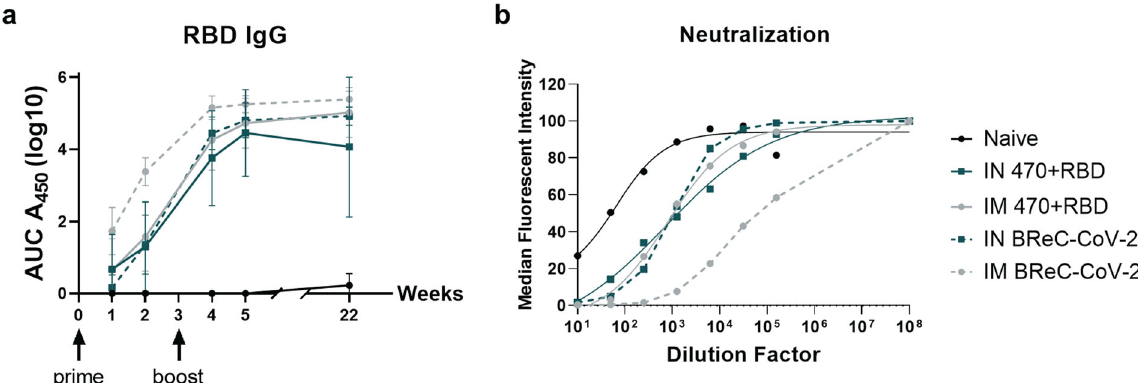
Fig. 2 Analysis of antibody responses and neutralization capacity of IN and IM BreC-CoV-2 vaccines. CD-1 mice were IN or IM vaccinated with BECC470 with RBD or RBD- EcoCRM ® in two doses. a Serum was taken at 1 week and 2 weeks post prime, 1 week and 2 weeks post boost and 22 weeks post boost. Log10 AUC450 values from RBD-IgG titers are depicted for each vaccine. Results shown as mean ± SD. b In vitro neutralization assay performed on the Luminex platform. Serum was obtained from 2 weeks post boost. Naïve represents the group that received no vaccine, BReC-CoV-2 denotes mice immunized with RBD- EcoCRM ® adjuvanted with BECC 470, 470 represents BECC470 adjuvant, and receptor binding protein